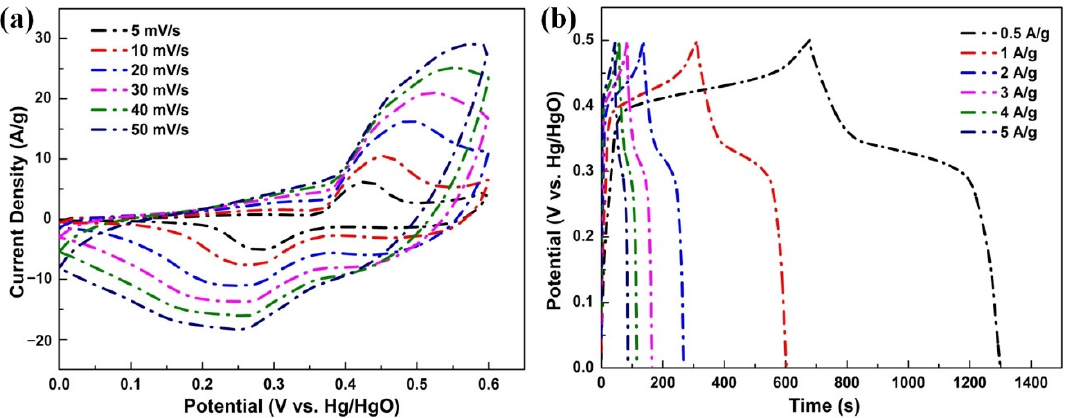
Figure 5. ( a ) CV curves of NiO x @GR-C2 at varied scan rates. ( b ) GCD curves of NiO x @GR-C2 at different current densities.